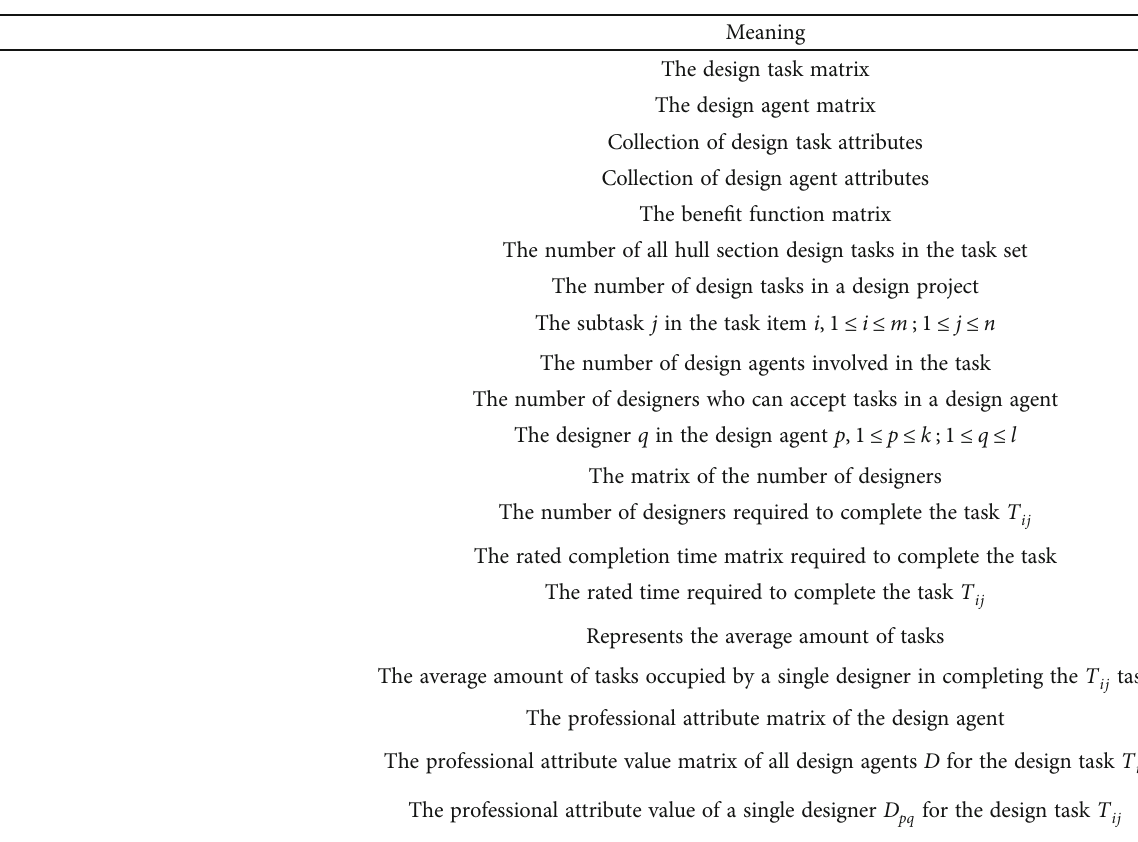
Table 1: Model elements de fi